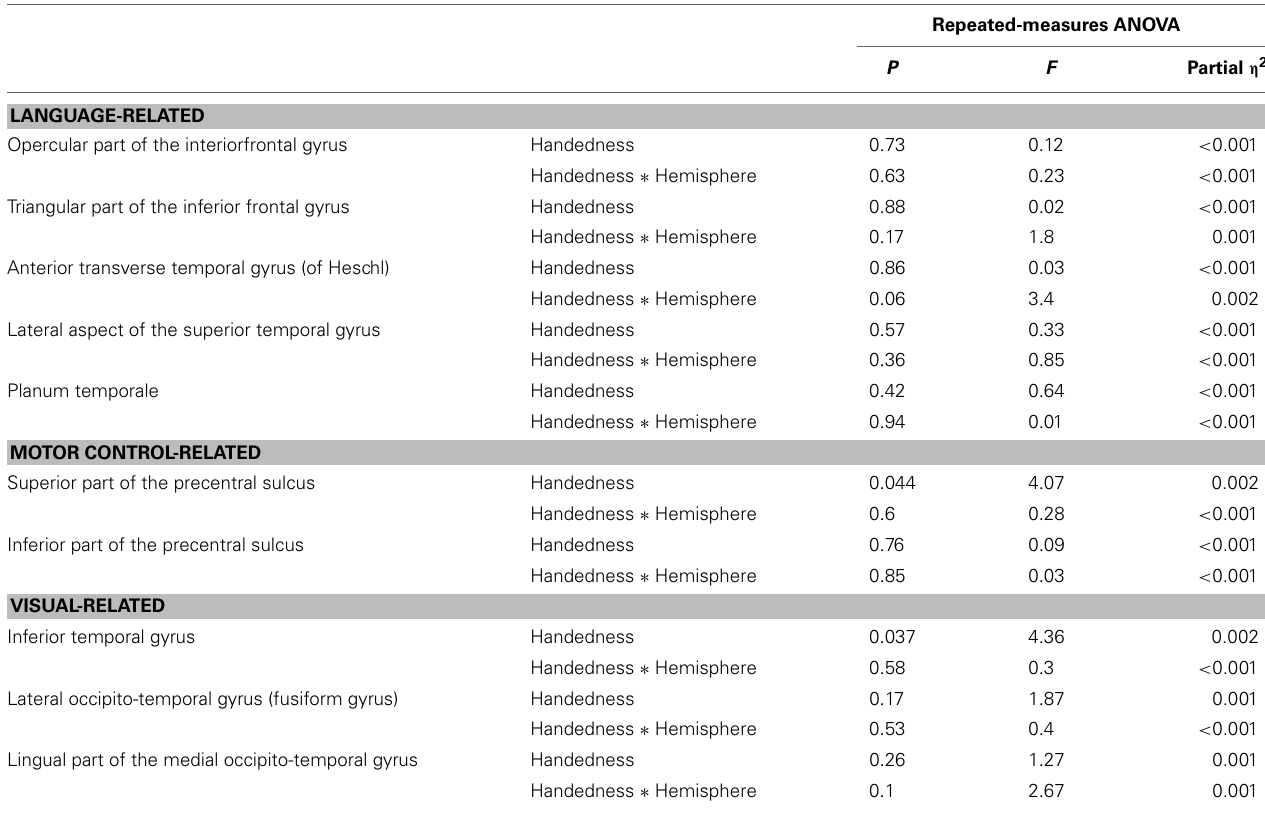
Table 3 | Summarized results for the candidate cortical